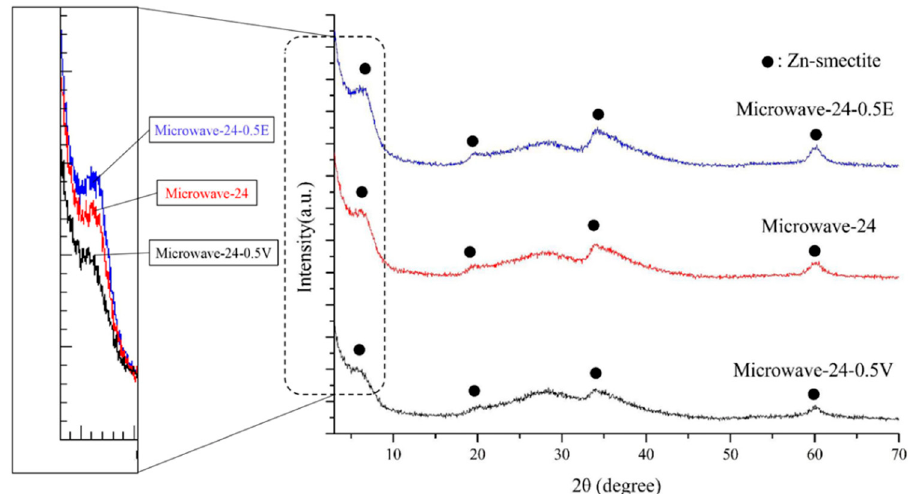
Figure 3. XRD pattern of Zn-saponite synthesized using the microwave circulating reflux method with different parameters.